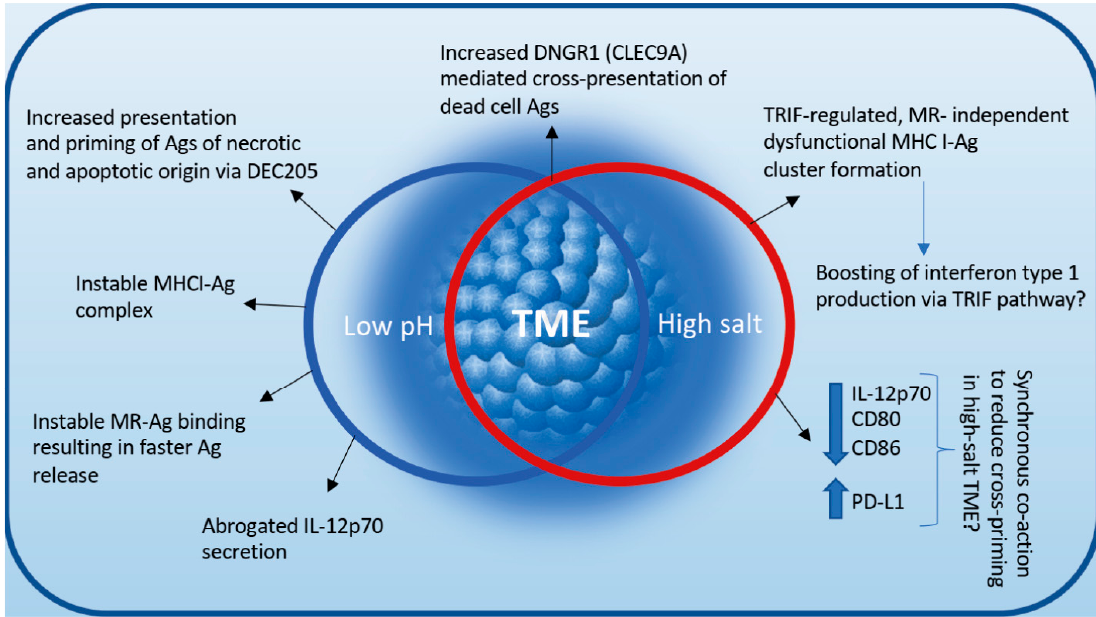
Figure 2. Impact of acidic and hyperosmolar tumor microenvironment (TME) on cross-presentation and cross-priming cascade is dynamic and complex. Interplay of low pH- and high Na + - triggered phenomena likely decides the fate and e ffi cacy of cross-presentation. Also here can be postulated that tumor nature and viability (in regard to apoptotic and necrotic rate) partially shape the receptor–antigen binding signature and thus contribute to the response of cDC1 to biophysical TME